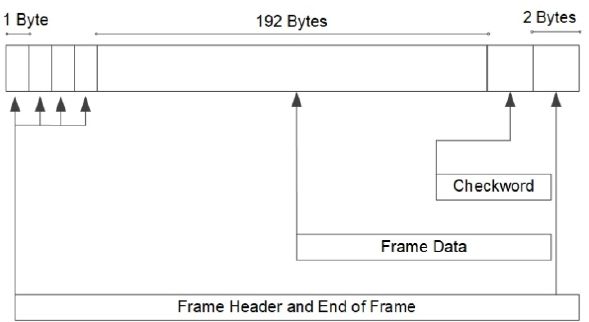
Figure 7. Packet structure of data transmission.